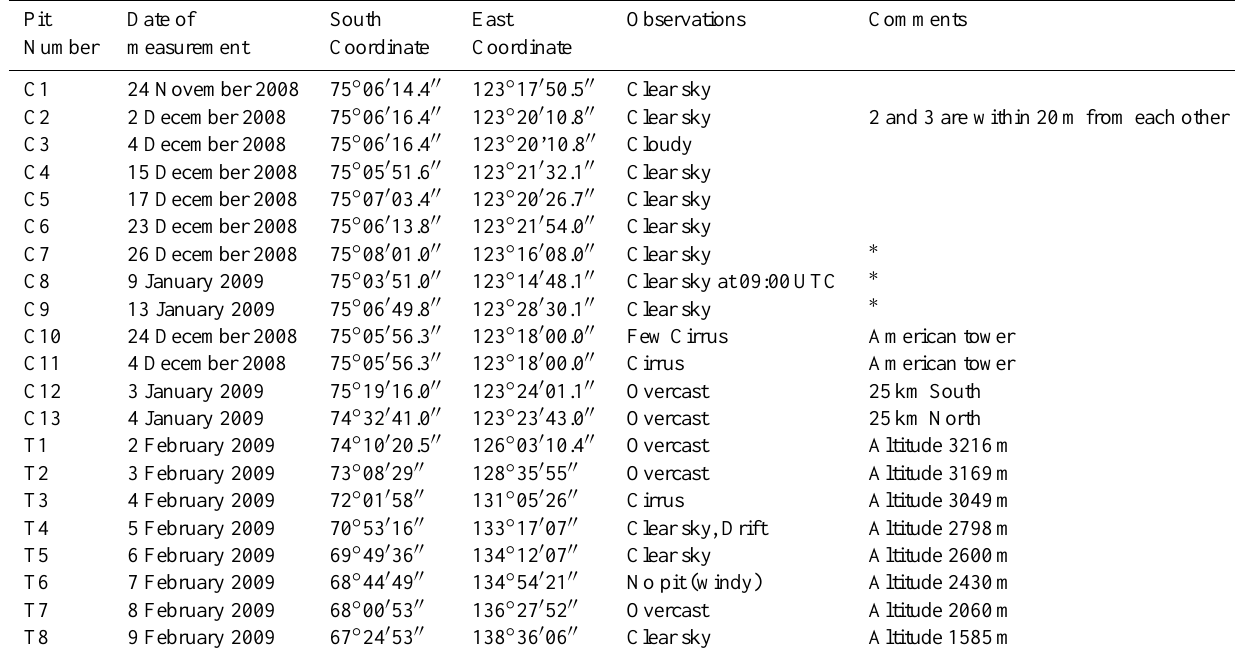
Table 1. Coordinates of group C and T